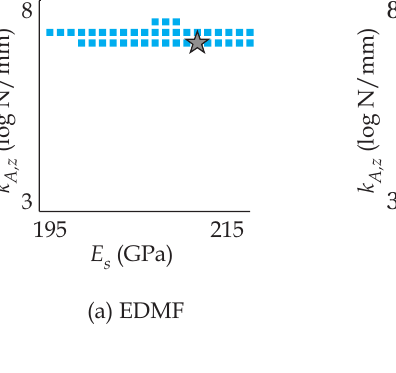
Figure 6. Samples from updated parameter distributions obtained using: ( a ) EDMF; ( b ) modified BMU; and ( c ) traditional BMU after retrofit of the Ponneri